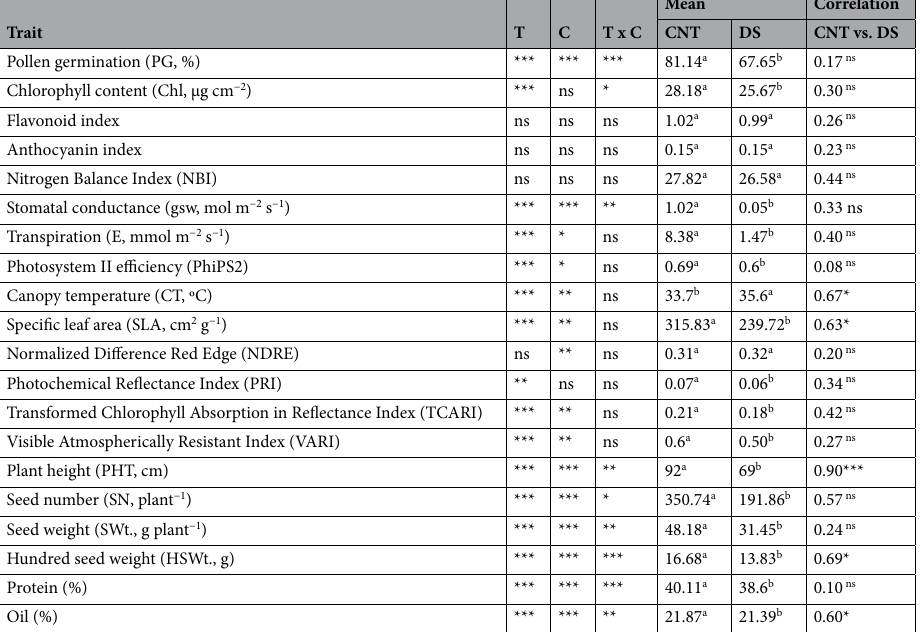
Table 1. Analysis of variance and mean values of physiology, leaf reflectance properties, yield, and seed quality parameters of ten soybean cultivars (C) under control (CNT) and drought stress (DS) treatments (T). *, **, and ***, indicate significance levels at p < 0.05, p < 0.01, p < 0.001, respectively. ns, indicates nonsignificance. The mean values were separated using the least significant difference (LSD) test at p ≤ 0.05. Different letters in superscript indicate the significant treatment effect. The correlation value determines the interdependence between the control and drought stress for the studied